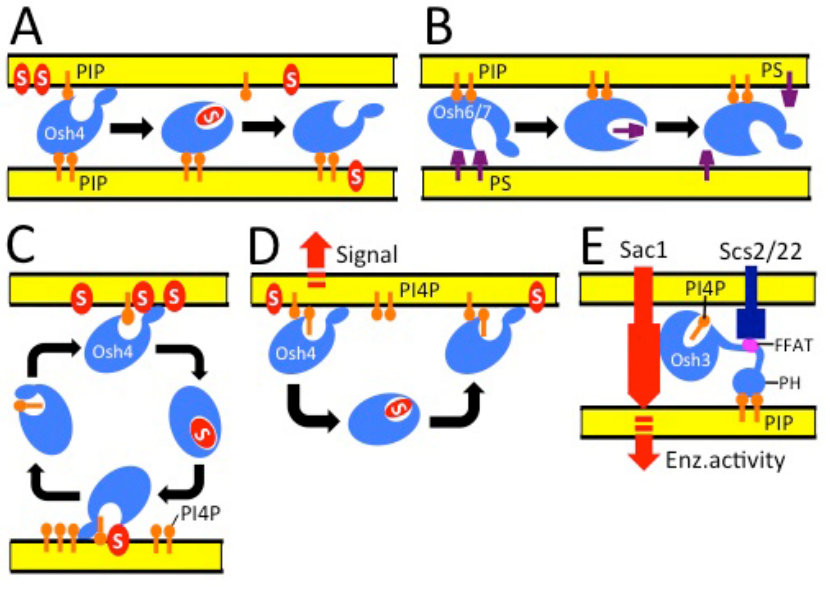
Figure 3. Models for the functions of yeast Osh proteins. ( A ) Osh4p acts at an ER-PM contact site, employs two membrane binding surfaces to associate with the bilayers via interactions with phosphoinositides (PIP) and other phospholipids, and transfers sterols (S) from one membrane to another [38]. ( B ) Osh6p and Osh7p transfer phosphatidylserine (PS) from the ER to the PM at membrane contact sites [59]. ( C ) Osh4p binds sterols (S) and phosphatidylinositol-4-phosphate (PI4P) in an exchange-type fashion within the same pocket, and transfers these two lipids in opposite directions [51]. ( D ) Osh4p binds to membranes of the trans -Golgi network and endosomes via interactions with PI4P. This association has a signaling function, and is negatively regulated by sterol binding to Osh4p, which detaches the protein from membranes [55]. ( E ) Osh3p acts at an ER-PM contact site, where it interacts with ER VAP proteins (Scs2p and -22p) through its two phenylalanines in an acidic tract (FFAT) motif and with PIPs via both its pleckstrin homology (PH) domain and the ORD ligand-binding tunnel, which accommodates PI4P. Osh3p controls the activity of the PI4P phosphatase Sac1p, an integral ER membrane protein, towards its substrate PI4P at the PM